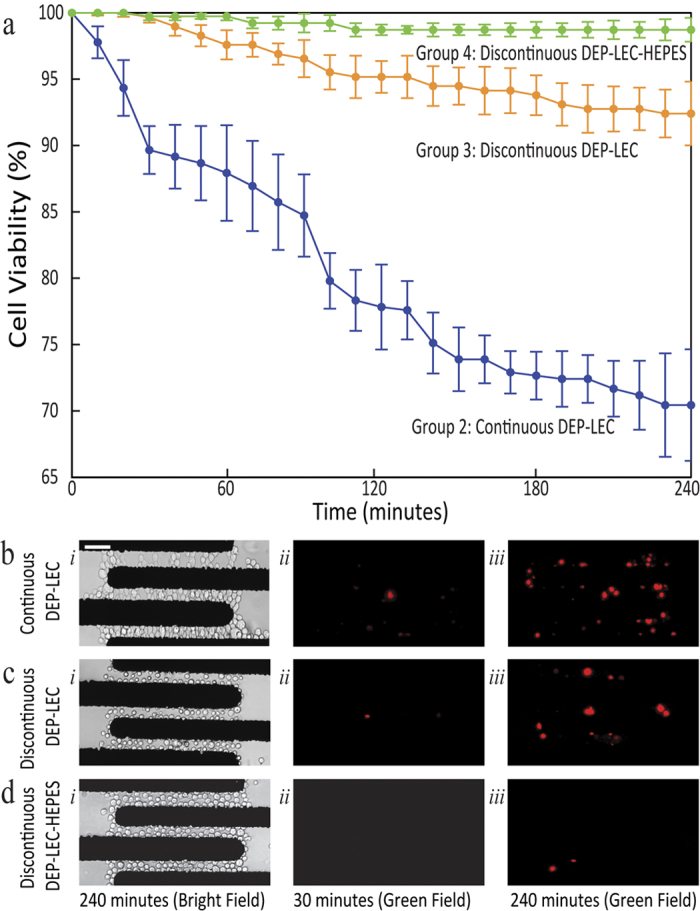
Viability of the Cells.(a) The viability of immobilised cells is displayed for three different groups, including group-two: continuous DEP-LEC, group-three: discontinuous DEP-LEC, and group-four: discontinuous DEP-LEC-HEPES. In all cases, fresh suspension medium either, LEC or HEPES was supplied continuously over 240 min, at a low flow rate of 2.5 μl/min. (b–d) Experimental results for each experimental group. (i) Bright field image, after 240 min, presenting the entire population of both viable and non-viable cells. (ii) Fluorescence images, highlighting the non-viable cells after 30 min. (iii) Fluorescence images, highlighting the non-viable cells after 240 min. Data is representative of three to three independent experiments and error bars indicate mean ± SEM. Scale Bar: 50 μm.